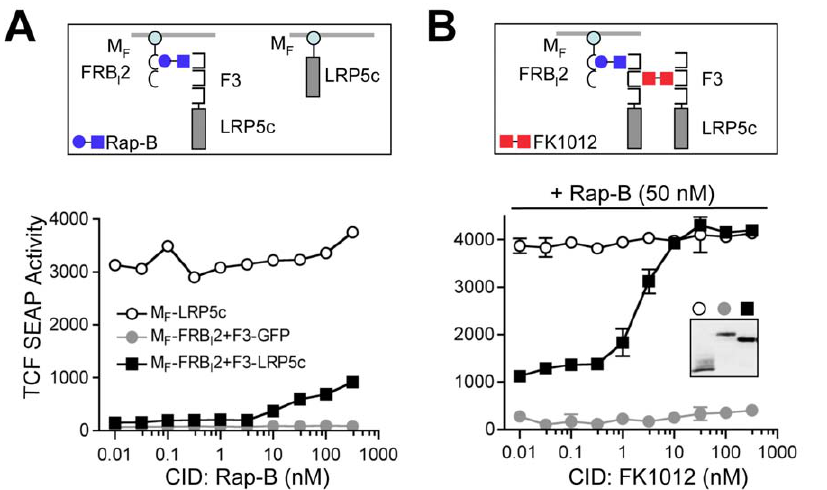
Figure 1. LRP5 forms constitutive dimers and CID-mediated dimerization of LRP5 induces TCF/ b -catenin activity. Schematics (top) and TCF reporter activity (bottom) of CID-mediated membrane translocation ( A ) with dimerization ( B ) of the LRP5 cytoplasmic domain (LRP5c). 293 cells were transiently transfected with TOP-SEAP reporter plasmid along with plasmids encoding myristoylated LRP5c (M F -LRP5c) or lipid raft-docking construct, M F -FRB l 2, along with either LRP5c fused to 3 tandem rapalog-binding domains (F3-LRP5c) or control protein, F3-eGFP. TOP-SEAP activity was measured 24 hours after administration of indicated amounts of Rapalog-B (Rap-B) ( A ) or homodimer (FK1012) along with suboptimal levels of Rap-B (50 nM) ( B ). Protein expression levels are indicated by anti-HA western blot (inset).